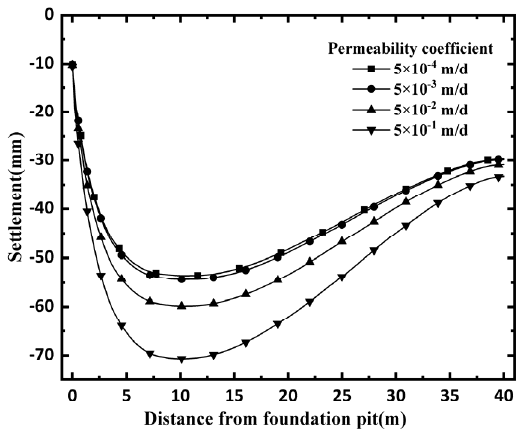
Figure 14. Settlement of different permeability coefficients without waterproof curtain.